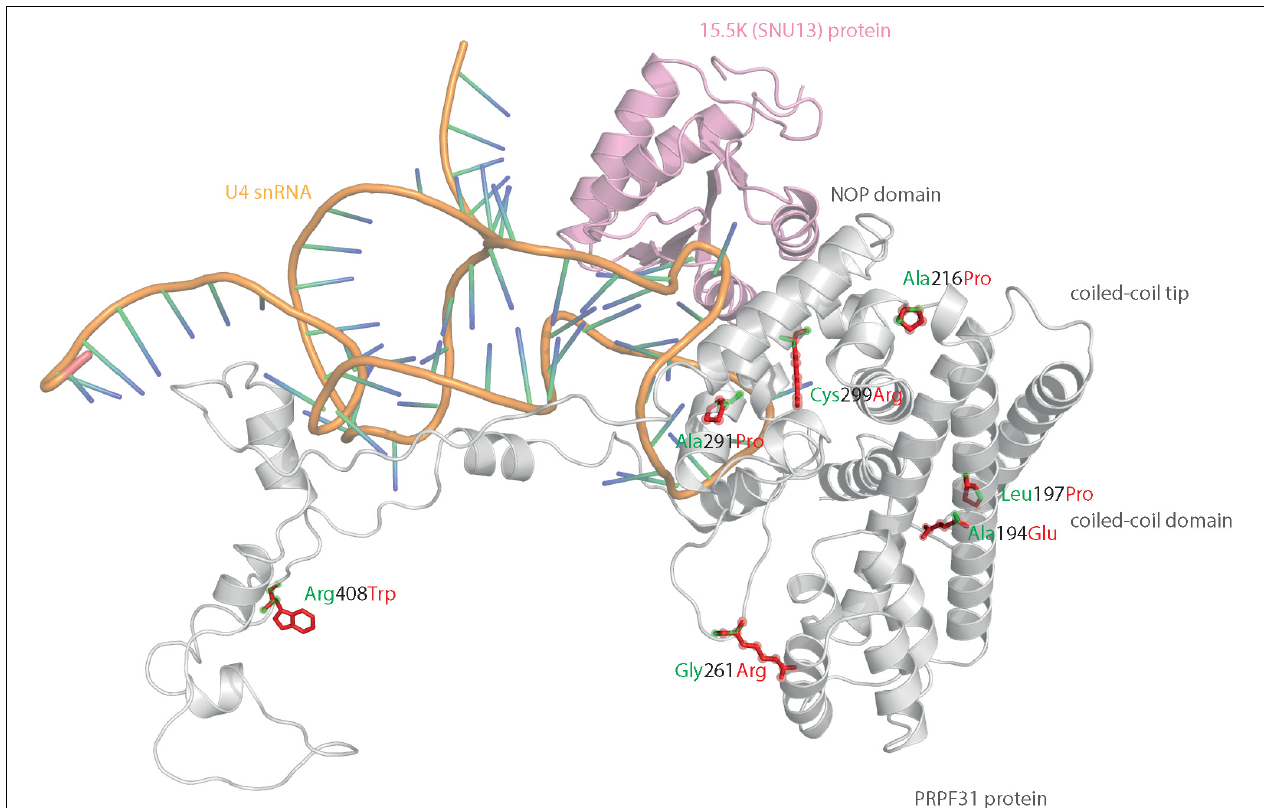
FIGURE 3 | 3D cartoon representation of PRPF31, including published missense mutations. Cartoon representation of alpha helical structure of PRPF31 (gray) and 15.5K/SNU13 (pink) with U4 snRNA (orange backbone), with published missense mutations mapped onto the physical structure, with wild-type amino acid structure in green, and mutant amino acid structure overlaid in